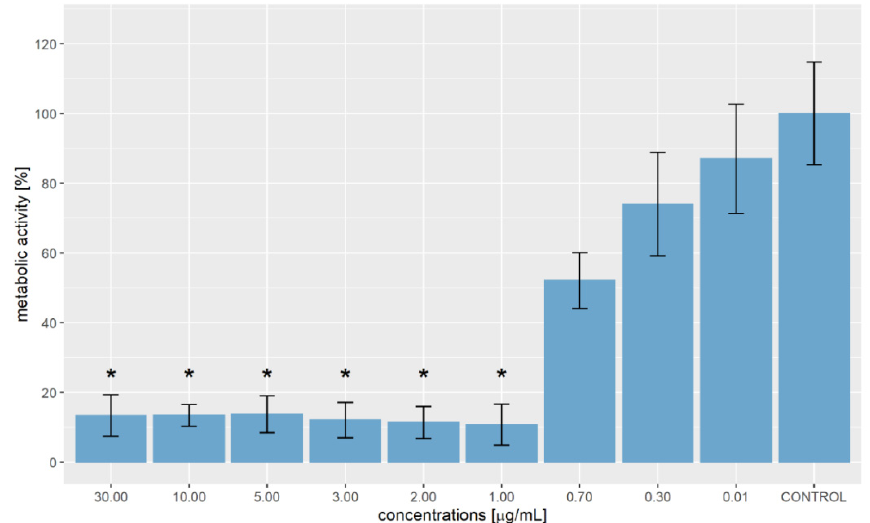
Figure 1. Metabolic activity of WM-266-4 cells exposed to different concentrations of hemp-ginger extract. Data generated in five replicates in each experiment for three independent experiments are shown as mean ± SD. Statistical significance, indicated with *, was defined as p < 0.050 compared with the control group (Kruskal-Wallis post hoc Dunn test).